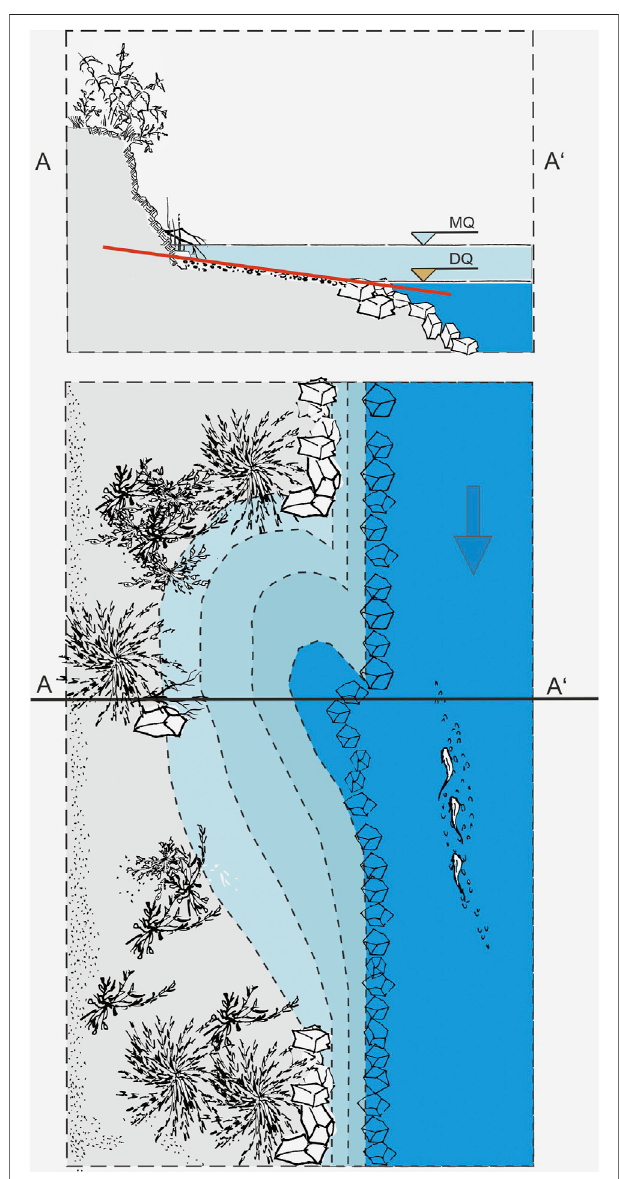
FIGURE8| Schematicsideviewandtopviewasasuggestionofhowto morphologically improve the restored bank habitats to avoid fi sh stranding with the indication of the mean water level (MQ) and the low water level (DQ) during the potential dewatering. Black line in top view with (A) to (A ’ ) indicate the location of the cross section displayed in the sie